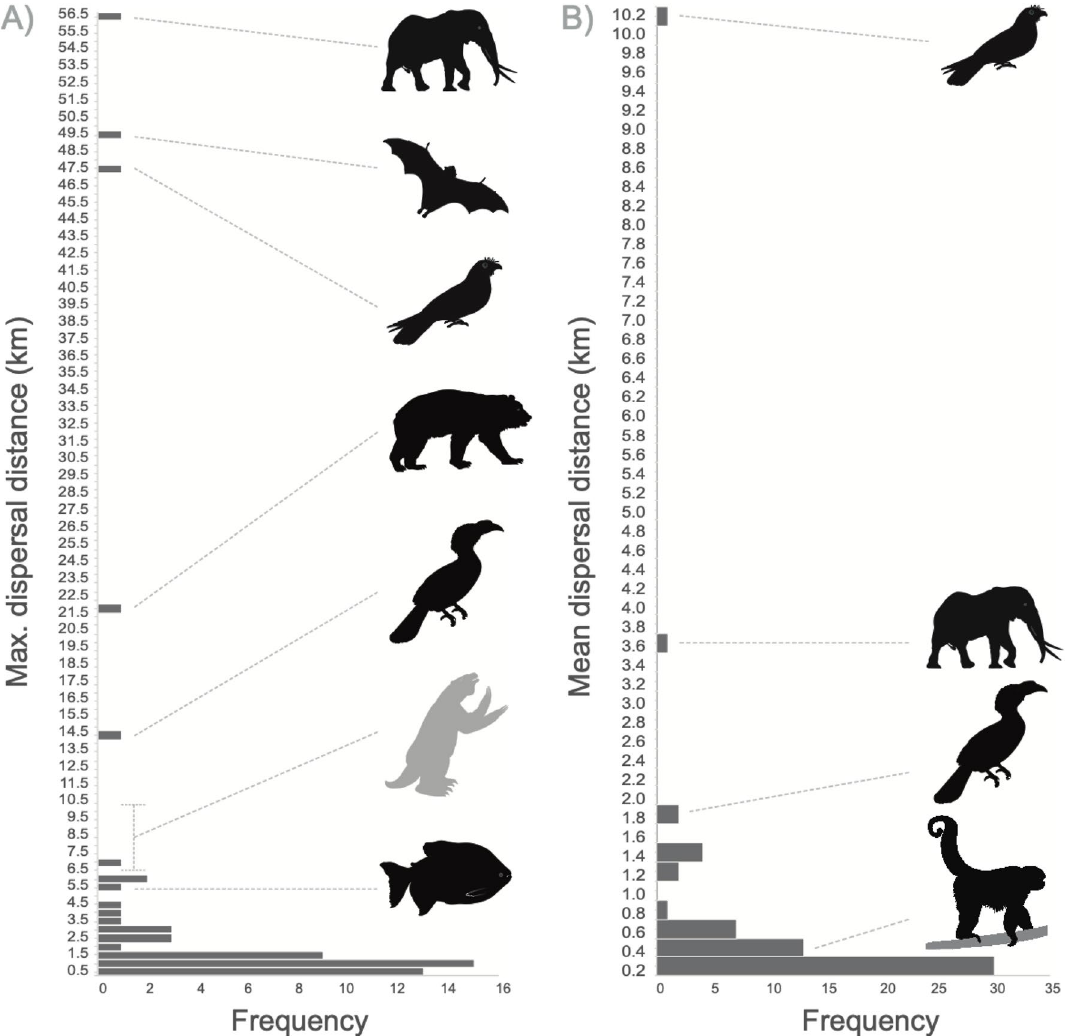
Figure. 3. Distribution of maximum ( A ) and mean seed dispersal distances ( B ) generated by a variety of animals worldwide. The parameters corresponding to oilbirds are indicated, as extreme outliers in both cases. The estimates of extinct megafauna are also indicated by the gray giant sloth (from Figs. a7-a9 in 23